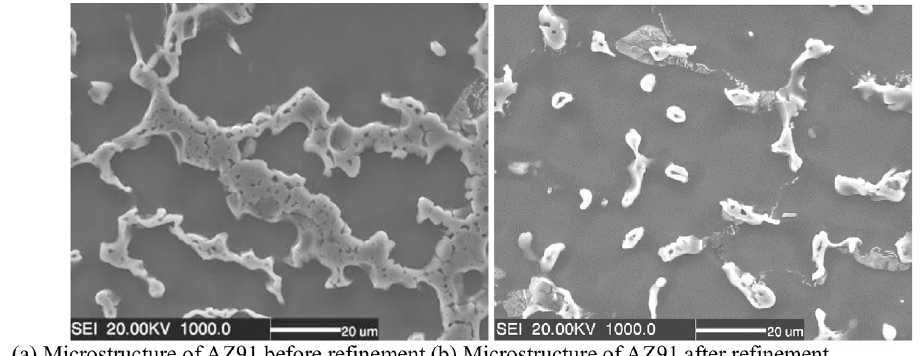
Fig 8. Microstructure of AZ91 before and after refinement. (a) Microstructure of AZ91 before refinement; (b) Microstructure of AZ91 after refinement.